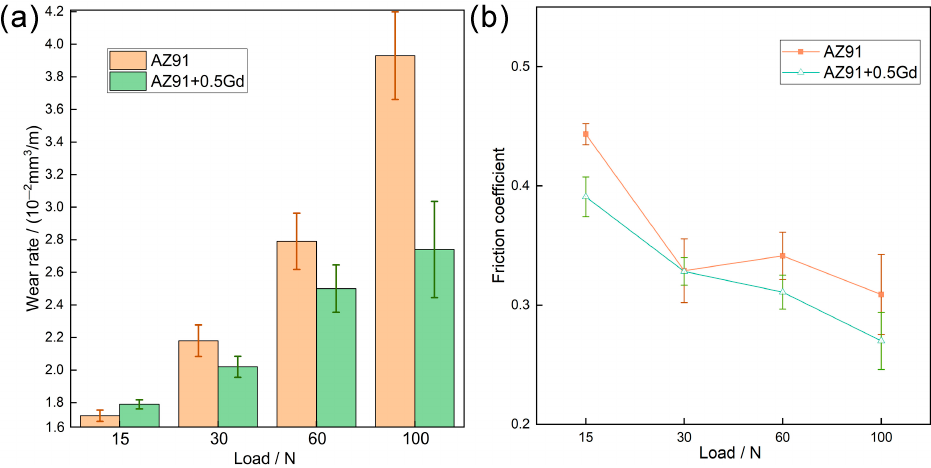
Figure 6. Results of friction and wear tests of surfacing magnesium alloys under different loads: ( a ) wear rate, ( b ) friction coefficient.